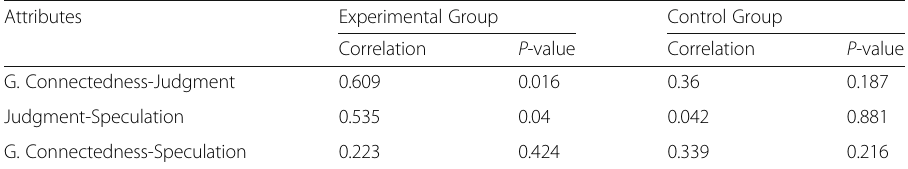
Table 7 Experimental and Control Group Correlations Attributes